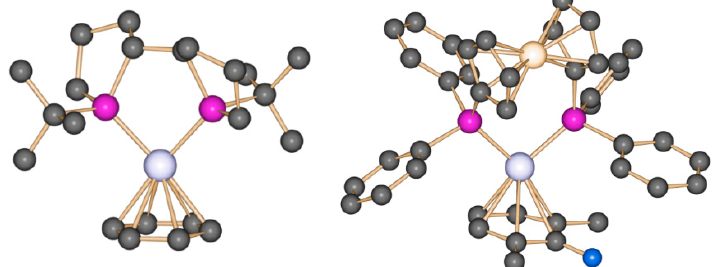
18 of 45 Scheme 10: Competitive, blue, uncompetitive, red, and mixed, blue and red, inhibition in enzyme catalysis. 4.1. Formation of Non-Reactive, Monomeric Species Well-known inhibitors for cationic Rh-complexes are carbon monoxide CO and diolefins such as COD and NBD, because the corresponding complexes possess very high stability constants. For example, it has been shown that when the hydrogenation of olefins is carried out in primary alcohols with a catalyst prepared in situ from [Rh(NBD)Cl] 2 and monophosphines such as PPh 2 Et catalyst deactivation takes place due to the formation of [Rh(CO)(PPh 2 Et) 2 Cl]. Under the reaction conditions, 50 °C and 1 bar H 2 , the catalyst is also able to promote the reduction of the olefin by transfer of hydrogen from the solvent alcohol. The resulting aldehyde can be decarbonylated by the catalyst with the ensuing formation of [Rh(CO)(PPh 2 Et) 2 Cl]. This species is catalytically inactive. Catalyst deactivation is enhanced at higher temperature and does not take place in the absence of the olefin